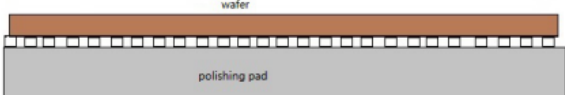
Figure 1: The contact between wafer and polishing pad